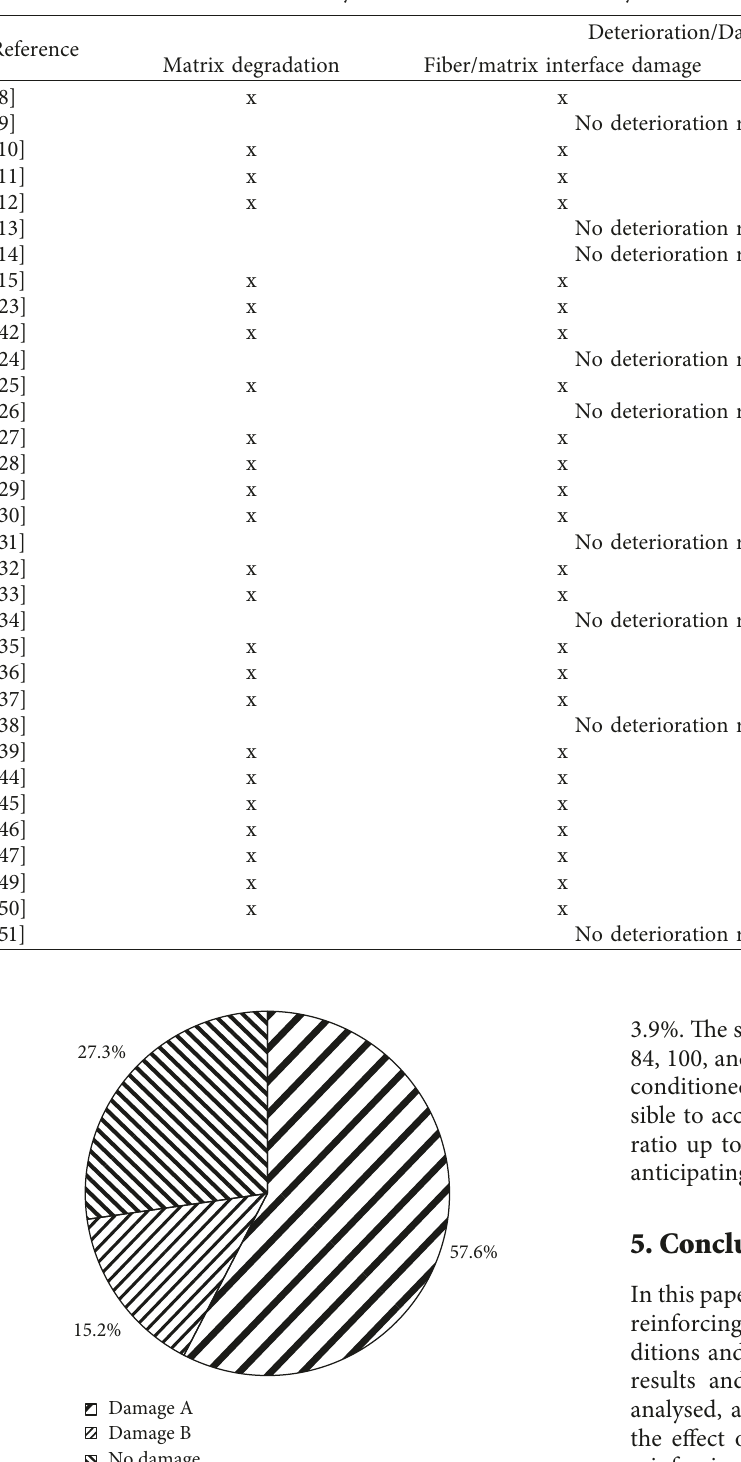
Table 12: Summary of deteriorations identified by SEM in conditioned GFRP reinforcing bars.